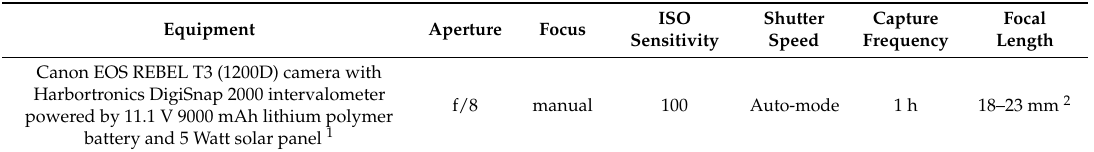
Table 2. Characteristics and settings of used time-lapse set.